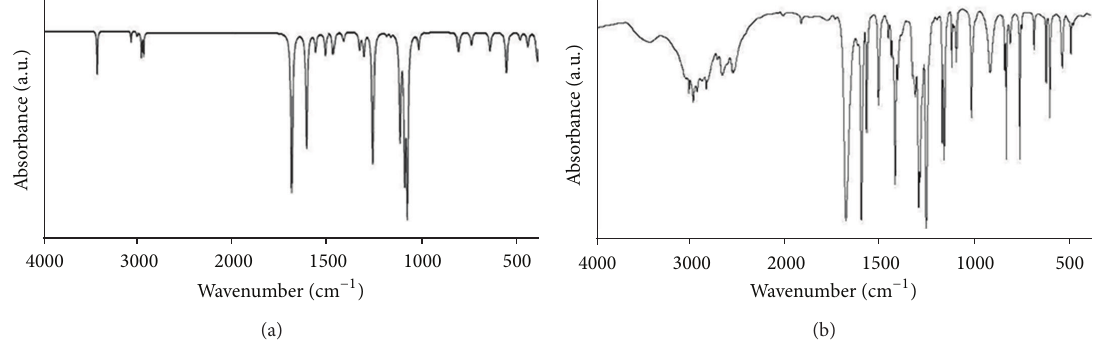
Figure 4: FTIR spectra of Anisic acid (a) observed and (b) calculated with B3LYP/6-31G ∗∗ .